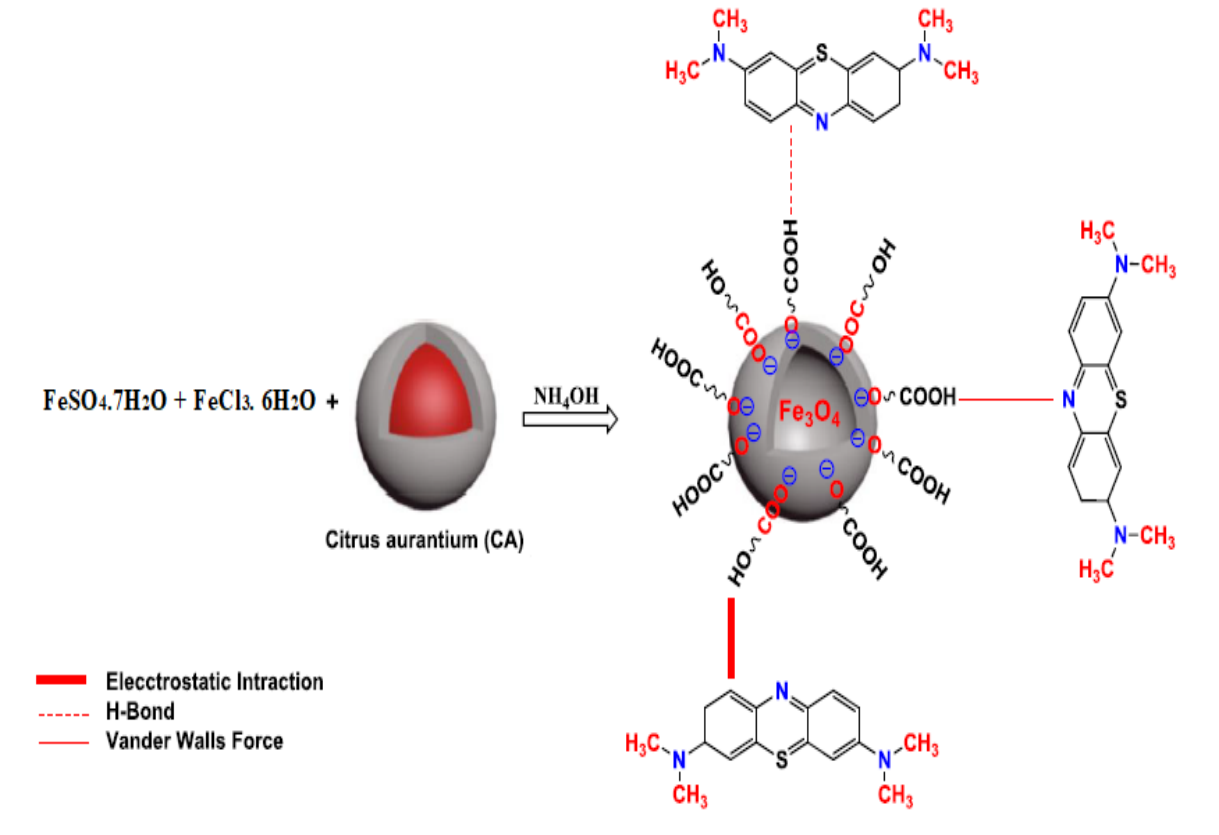
Figure 17. Proposed adsorption mechanisms of MB on Fe 3 O 4 .